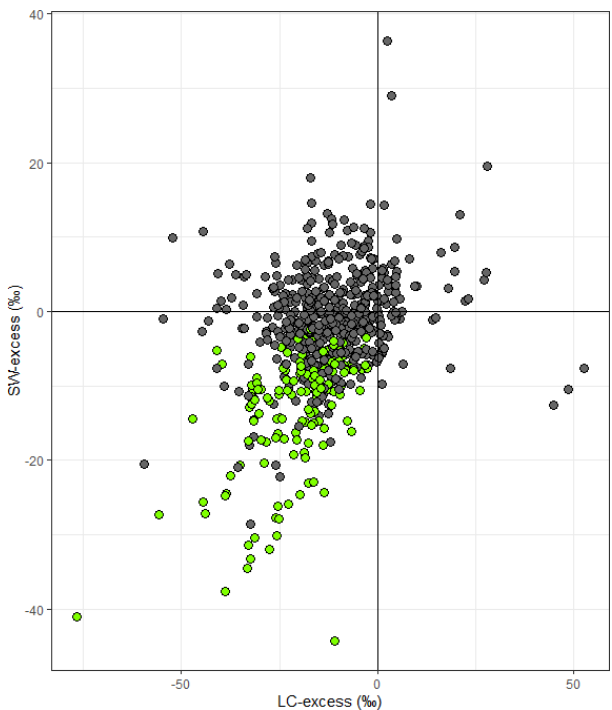
Figure 1. Soil water excess (SW-excess) plotted against line condi- tioned excess (LC-excess). Points are the mean values per species and campaign (observations from a given sampling event and plot within a study). Green symbols indicate observations where both LC-excess and SW-excess plus their corresponding standard error were negative. Error bars have been omitted for clarity. Note that the scales of the x and y axes are